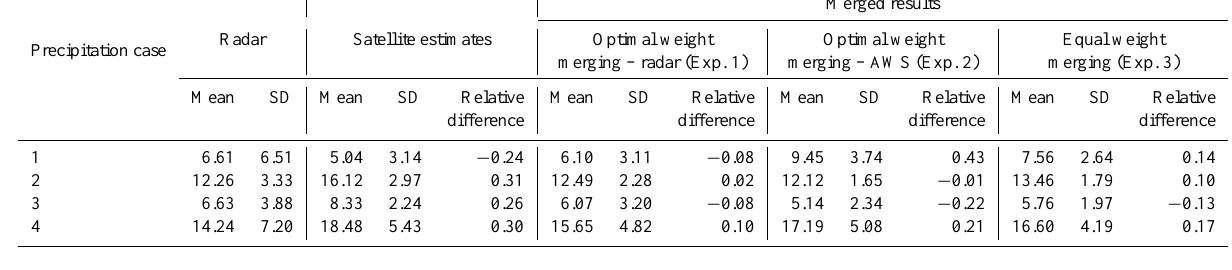
Table 2. Mean (mmh − 1 ) and standard deviation (SD) (mmh − 1 ) values of the radar observation, satellite precipitation estimates after bias correction, and radar-satellite merged results over the radar gap areas for the four precipitation cases. In this study, the relative difference indicates the ratio of the difference between the satellite estimates or merged results from the radar observation to the mean radar observation over the radar gap area.